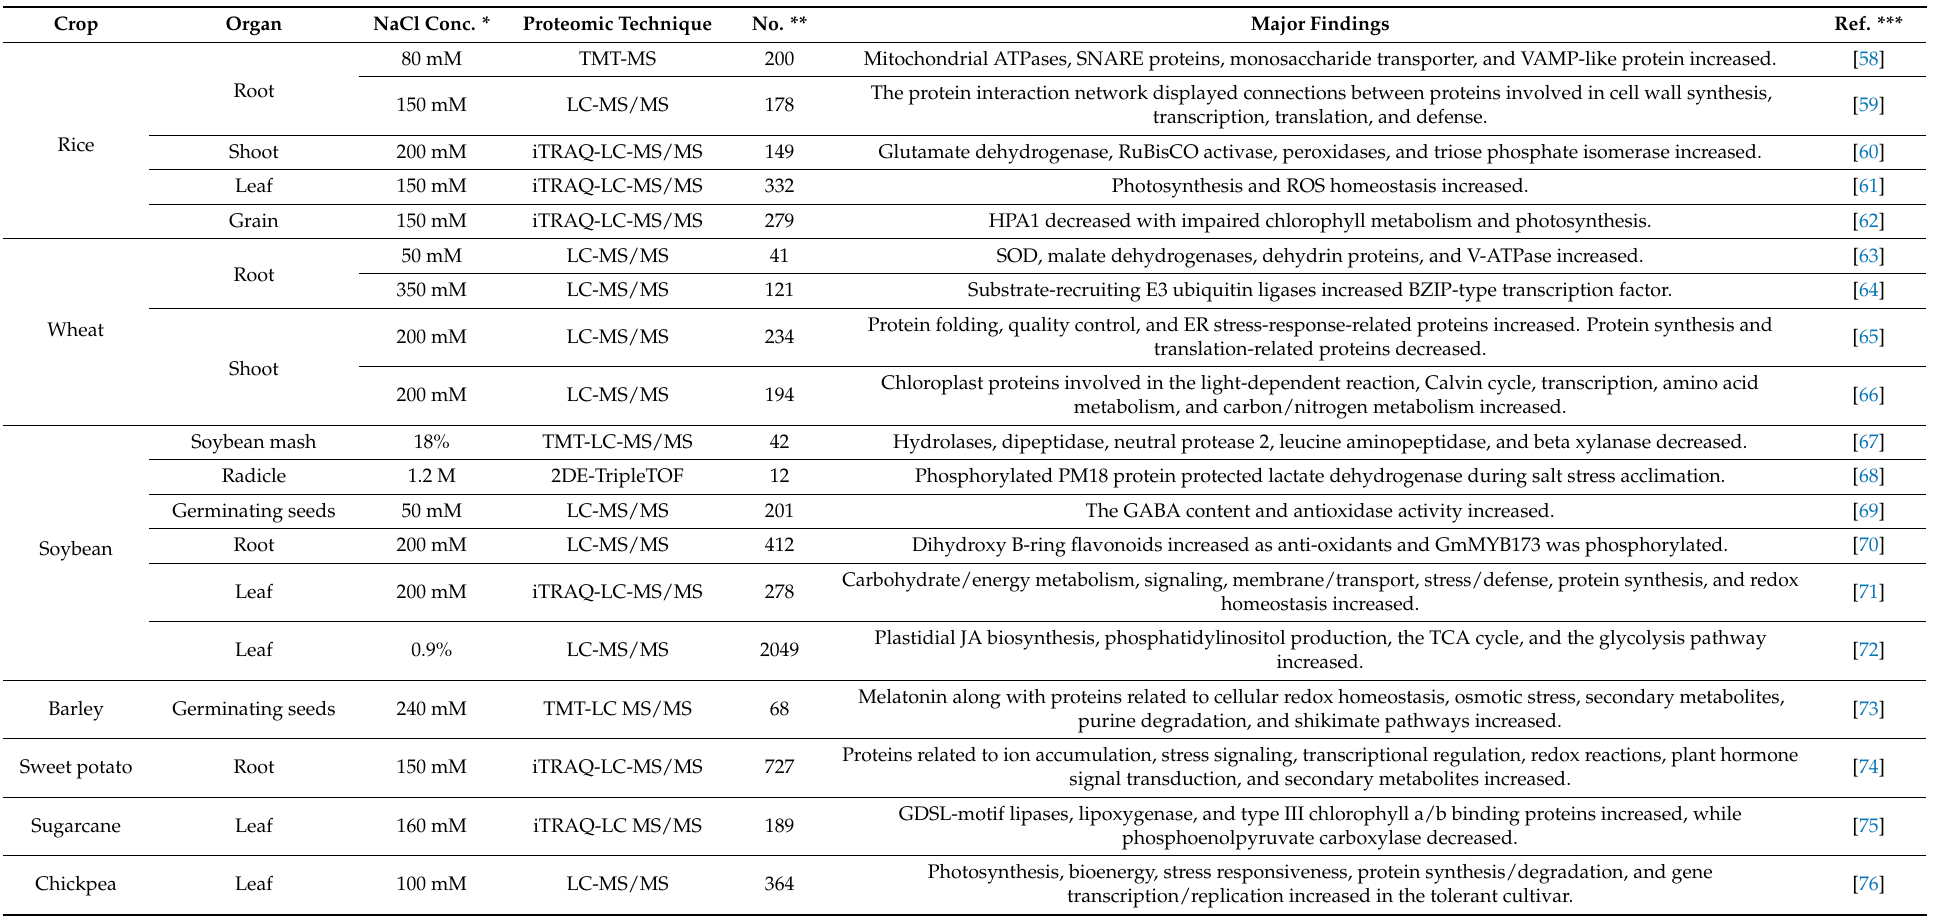
Table 2. Proteomic techniques used to analyze the salt response mechanism in crops studied during